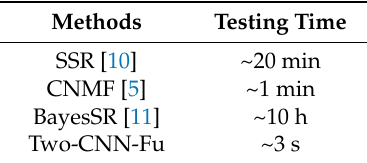
Table 9. Comparison of running time on the testing image.